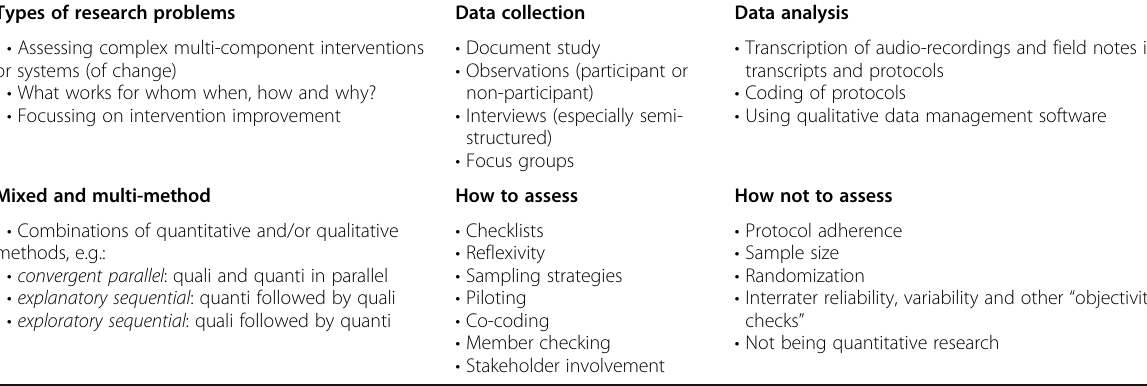
Table 1 Take-away-points Types of research problems Data collection